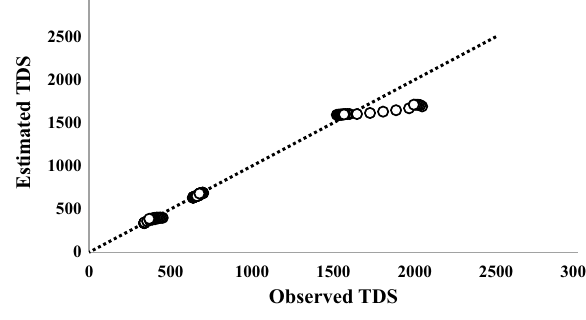
Fig. 8 Estimated TDS against observed values in the studied aquifer